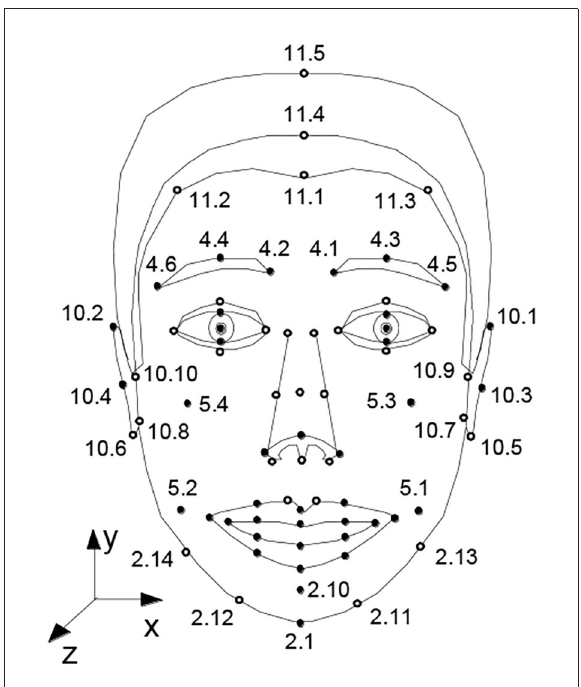
FIGURE2 The FDP defined by the MPEG-4(Standard